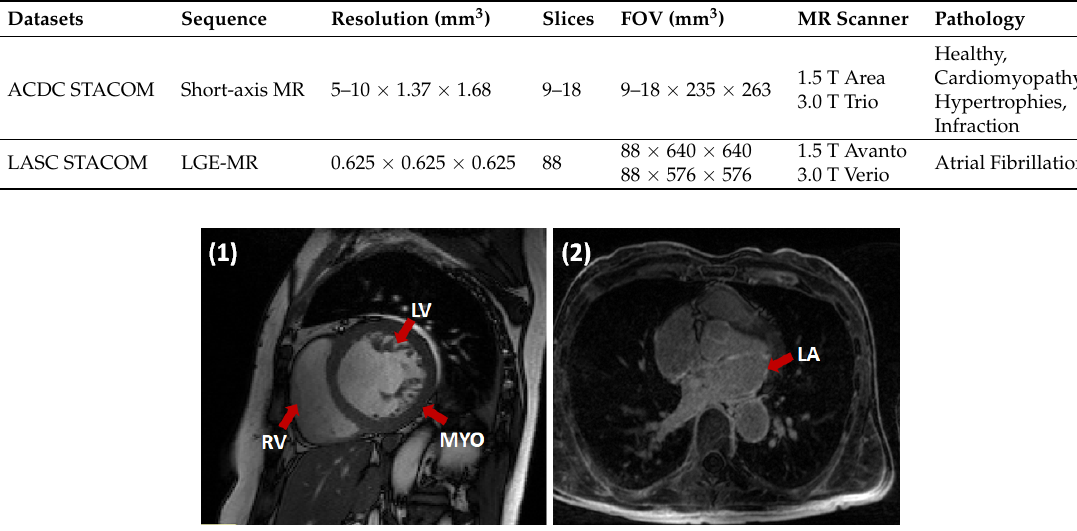
Figure 3. Examples of Cine short-axis (left) and LGE-MR (right) images with different heart structures. The red arrow points toward specific heart structure in different